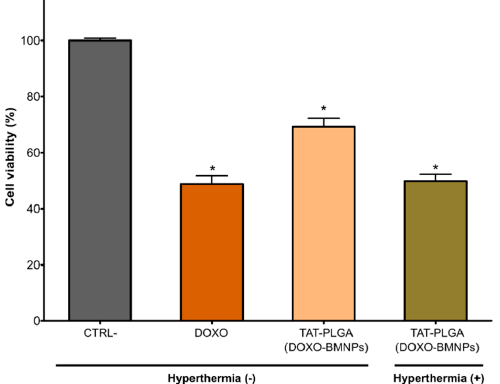
Figure 6. Cytotoxicity in HepG2 cell line following treatment with culture medium (control), DOXO (30 μ g/mL DOXO), and TAT–PLGA(DOXO-BMNPs) (containing 300 μ g/mL BMNPs and 30 μ g/mL DOXO) in the absence or in combination with magnetic hyperthermia. Data represent the means ± SEM of three independent experiments performed in triplicate; p ≤ 0.05 (*).